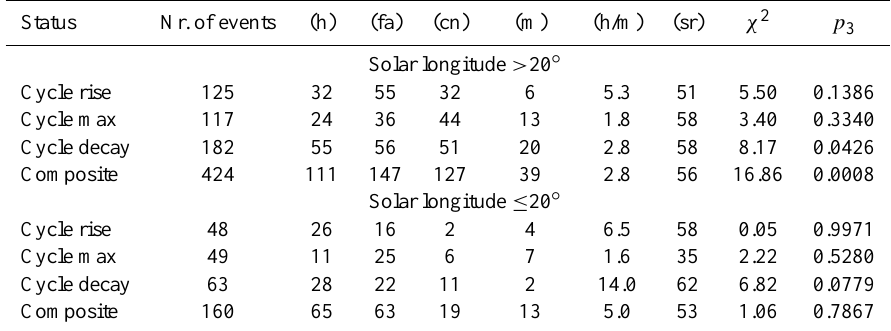
Table 7. Performance of the HAFv.2 model with respect to shocks associated with flares located at helio-longitudes > 20 ◦ (top four panels) and at heliolongitudes ≤ 20 ◦ (bottom four panels) during each of the key phases of solar cycle 23 and during the total